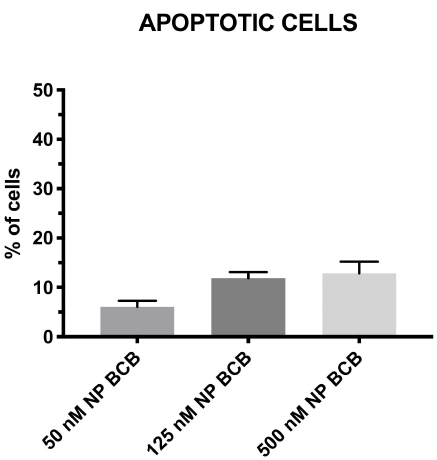
Figure 6. Standardization of BCB-nanoparticles’ concentration effect. BCB-nanoparticles were loaded with different concentration of BCB, n = 4. There were no significant differences noted of nanoparticles’ BCB concentrations on spontaneous cell apoptosis after treatment with N-BCB. Abbreviation: NP BCB (nanoparticles bax channel